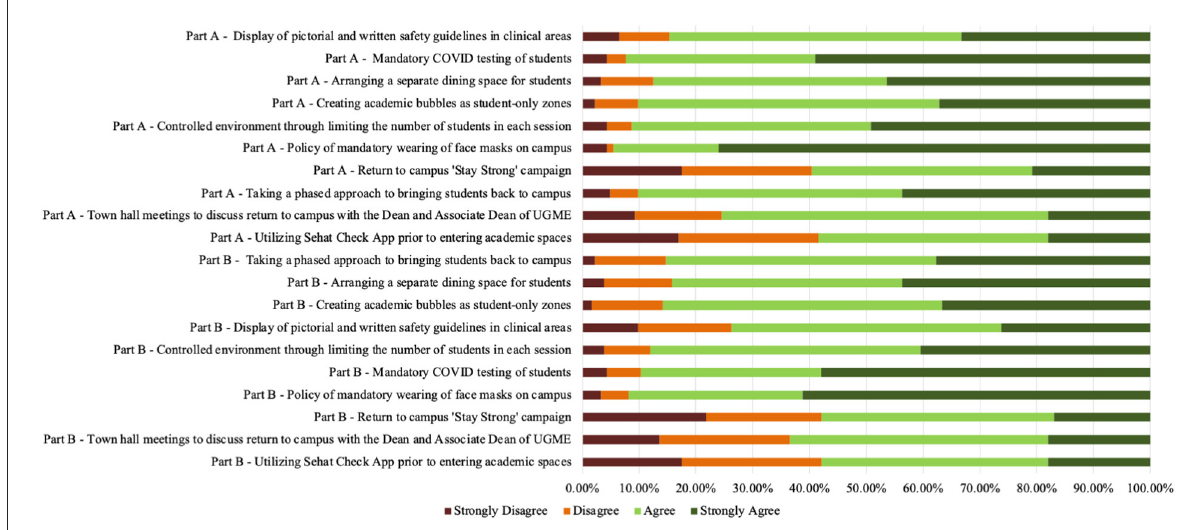
FIGURE2 Students’ degree of agreement/disagreement toward the efficacy of safety